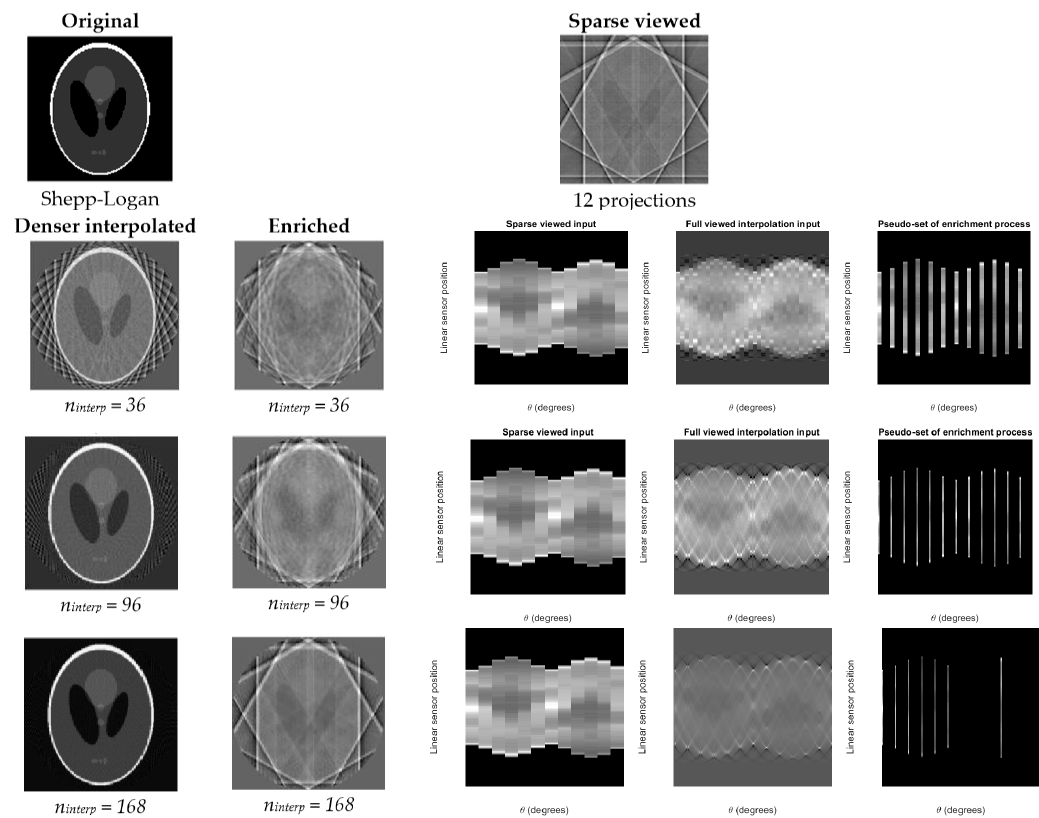
Figure 2. The reconstruction and sinograms illustration of the enrichment process of a sparse 12 projections (original, the first row), at the denser interpolated set of 36 (upper-left) (the second row), 96 (upper-right), and 168 projections (the third row).